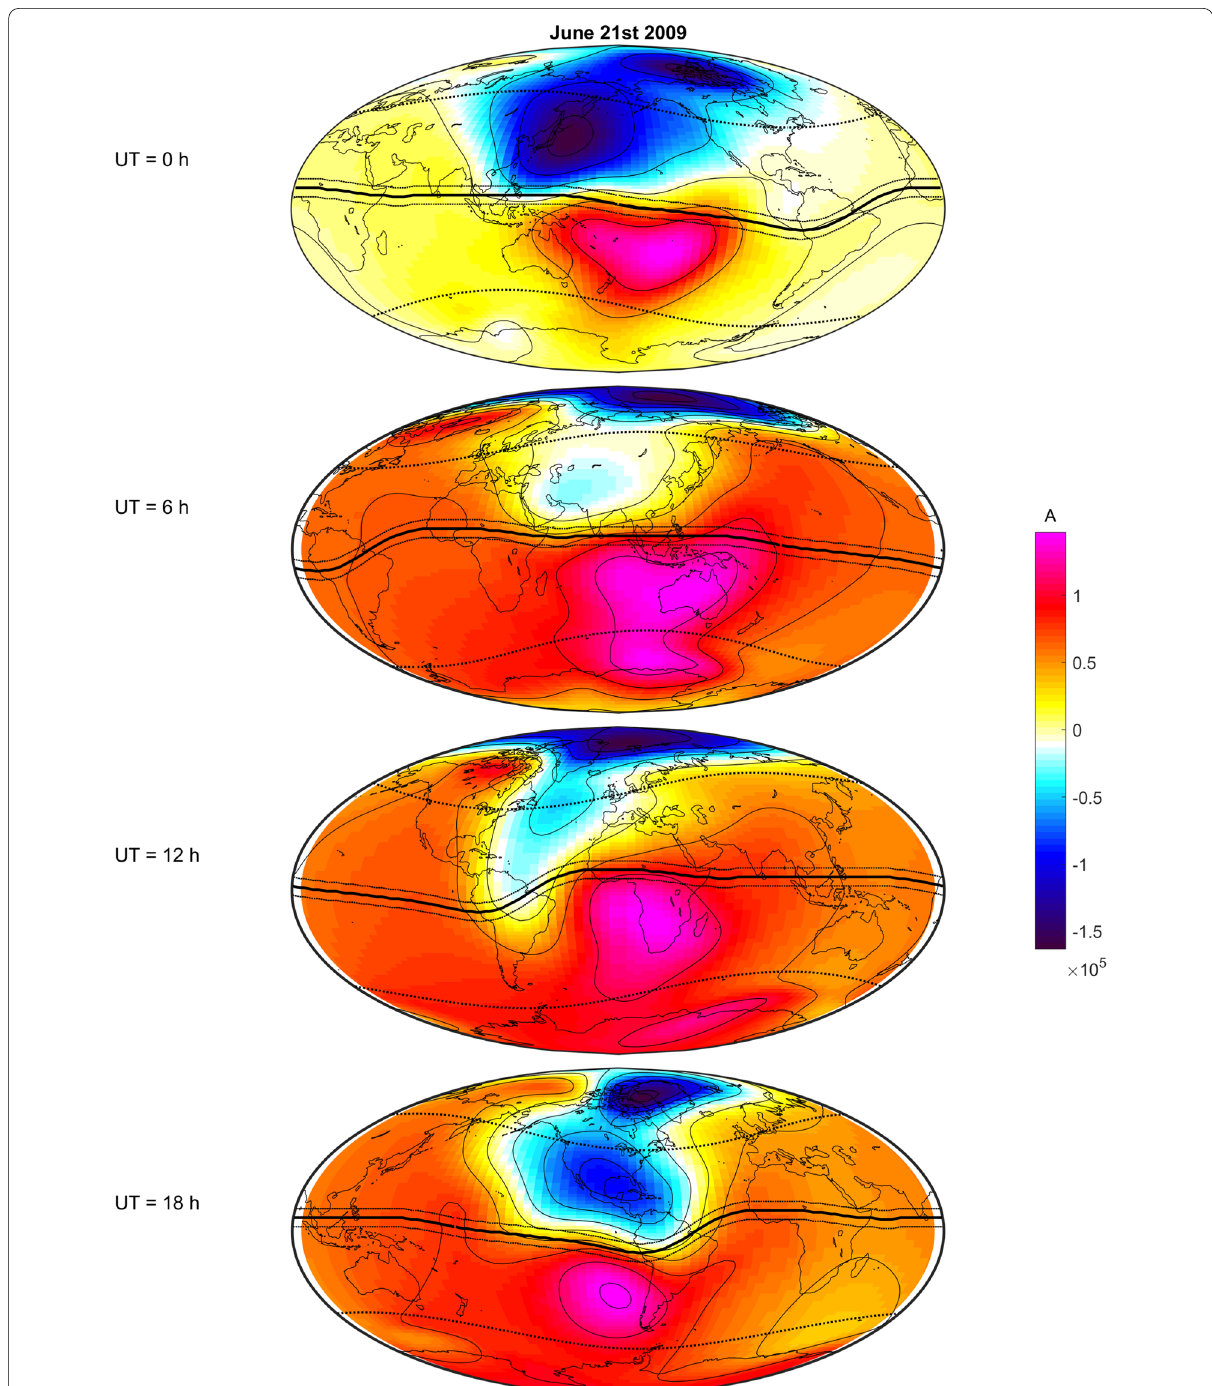
Fig. 2 Time snapshots of TIE-GCM stream function �( t ) on June 21 2009